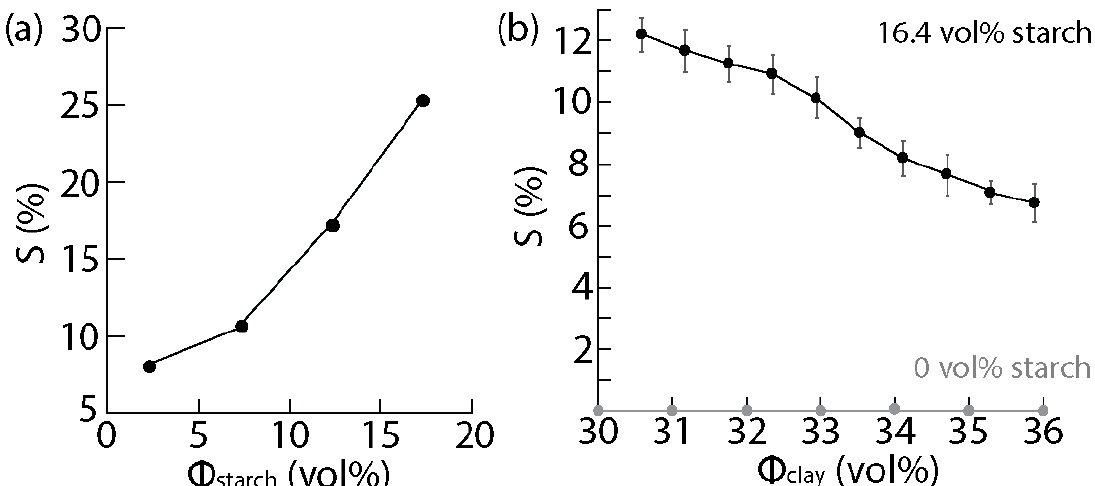
Figure 5. Shrinking of the matrix upon drying. ( a ) Shrinkage S as a function of the starch content in the pure starch hydrogel after drying; ( b ) Shrinkage S as a function of the solid loading in clay for the clay–starch–water mixtures with starch concentration of 16.4 vol% in the initial hydrogel suspension. In absence of starch, no shrinkage is recorded after drying.